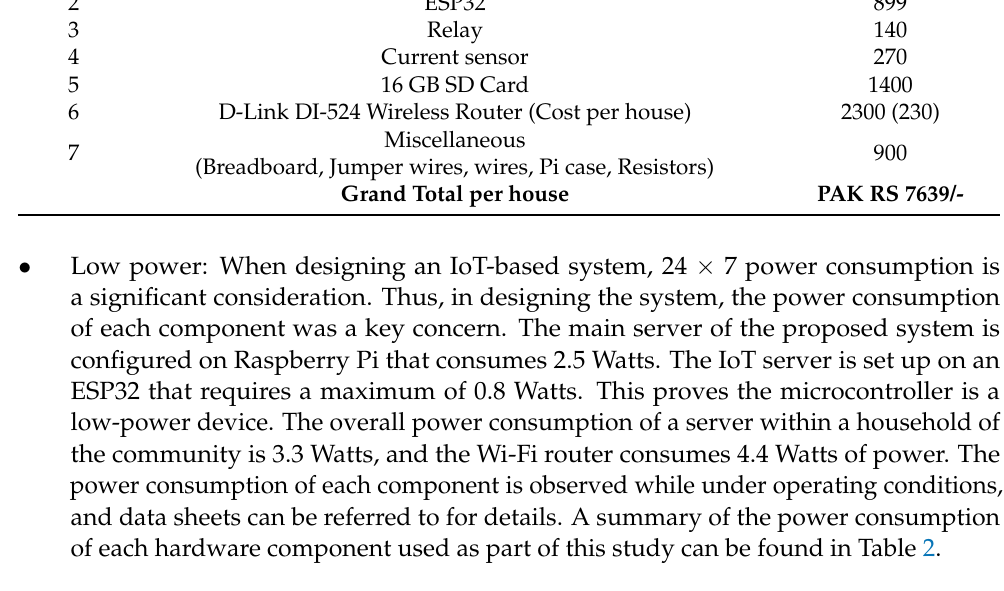
Table 2. Power requirement of the proposed